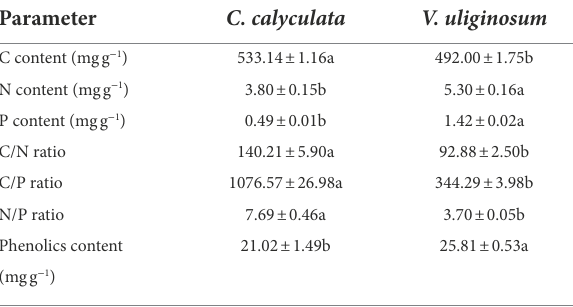
TABLE 1 The initial quality of the Chamaedaphne calyculata and Vaccinium uliginosum litter.